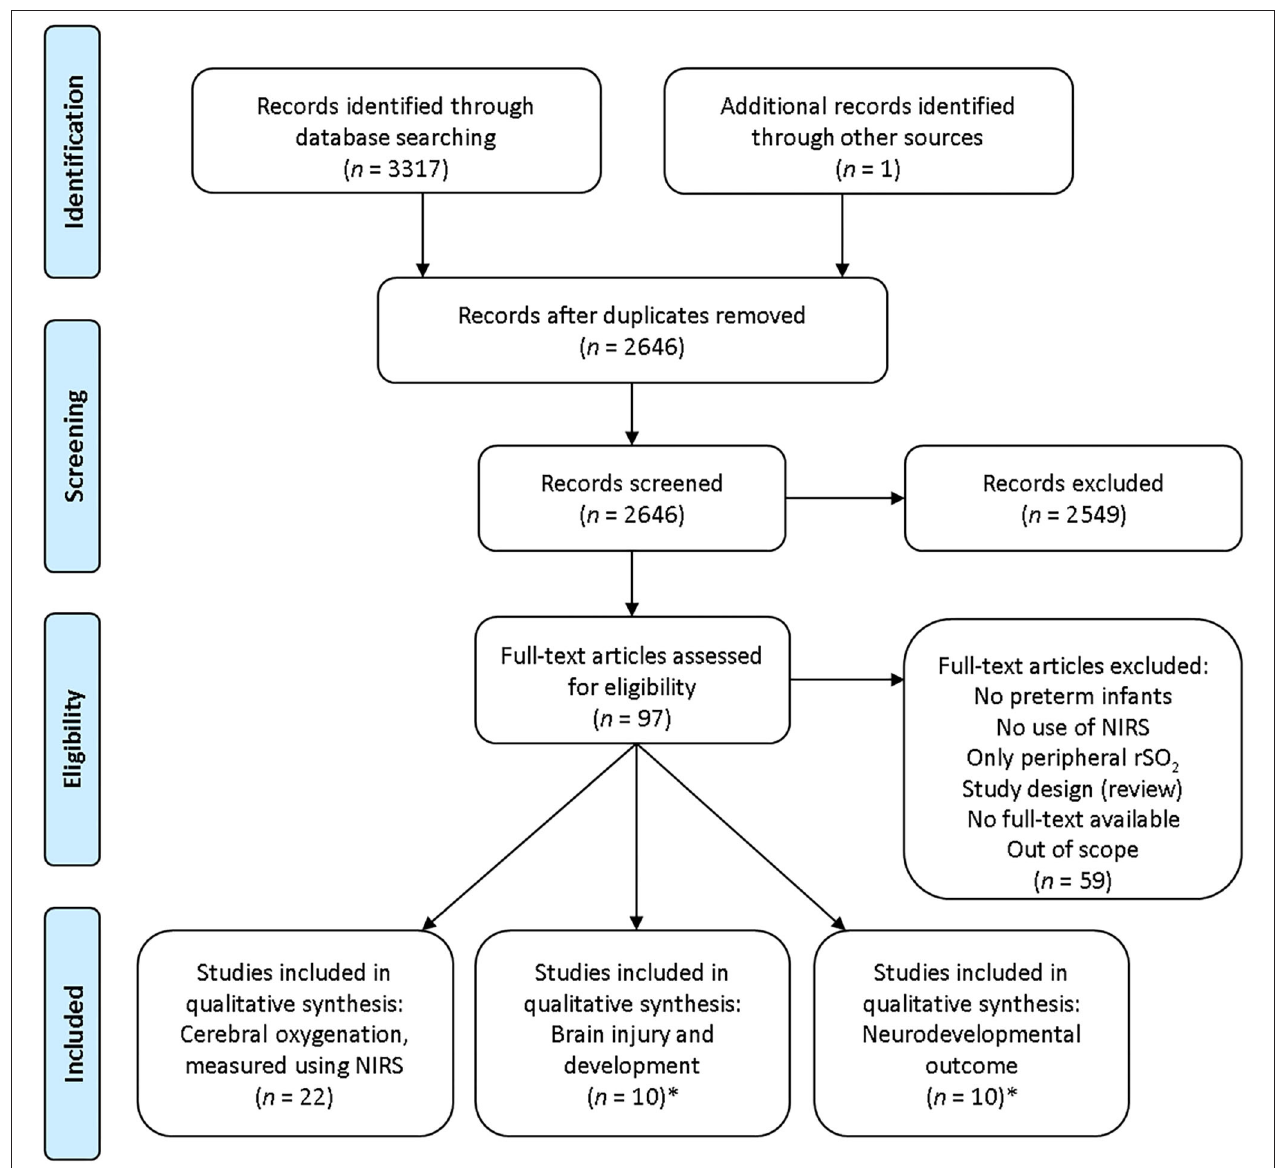
FIGURE 1 | Flow diagram search strategy. NIRS, near-infrared spectroscopy; rSO 2 , regional tissue oxygen saturation.*Four articles were eligible for both outcome 2 and